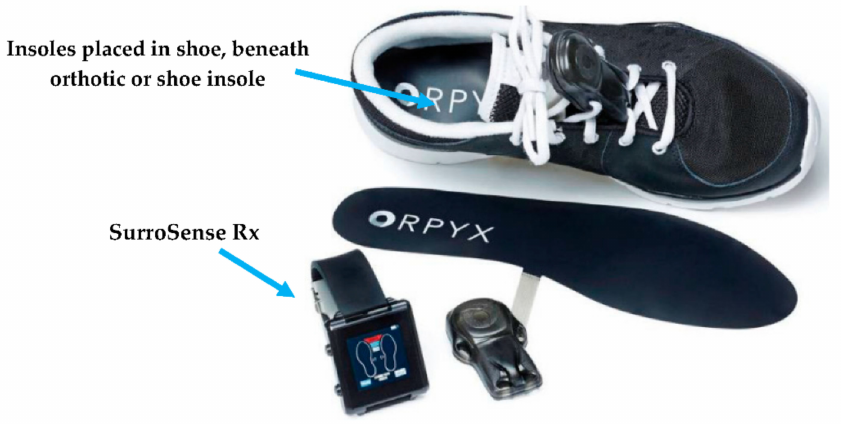
Figure 6. “SurroSense Rx” smart insole for curing plantar pressure during daily activities, Adapted from